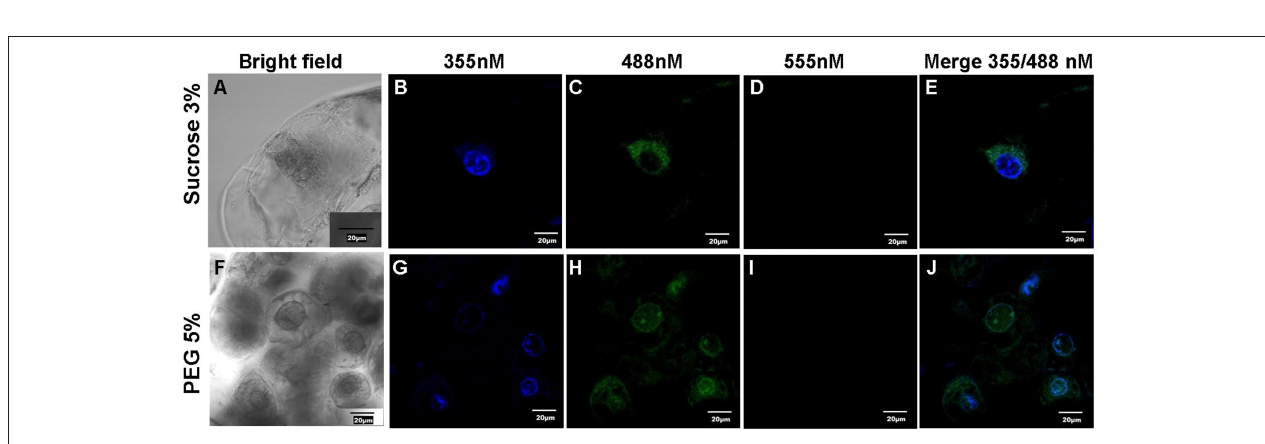
be reflected in the phase of the cell cycle in which most cells are located as they are not